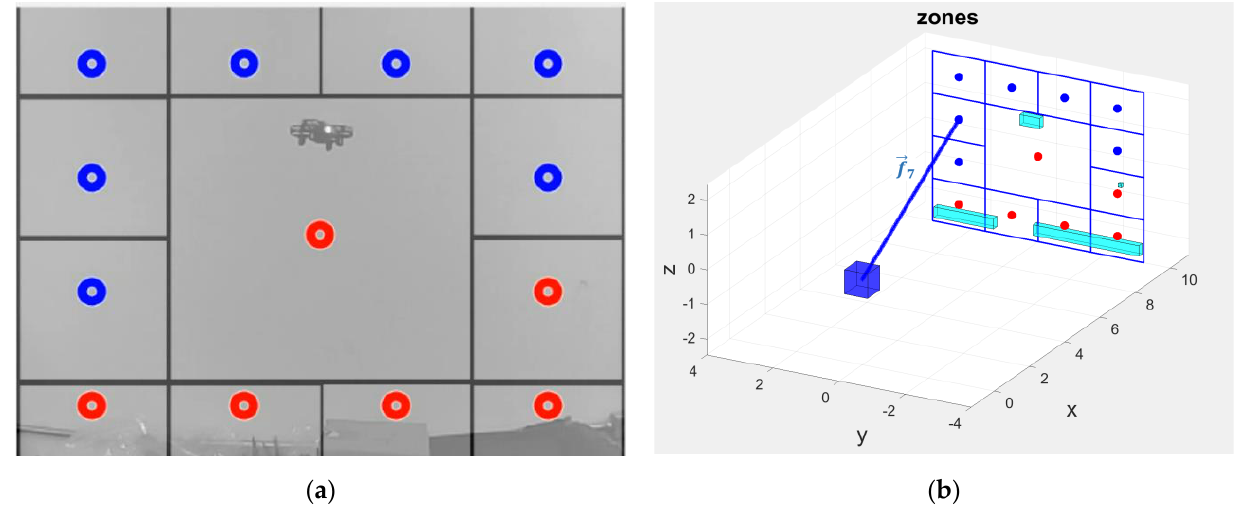
Figure 6. First experiment. ( a ) Frame acquired from the UAV video transmitted to the workstation, which is divided into regions: free regions marked in blue and collision regions marked in red; ( b ) graphical representation of vector reference 𝒇⃗ 𝟕 is selected for the controller, the reference originates from the drone and its endpoint is the central coordinates of the region 𝑅 7 . Table 3. Collision − free trajectories generated by object detection for frame shown in Figure 6a.